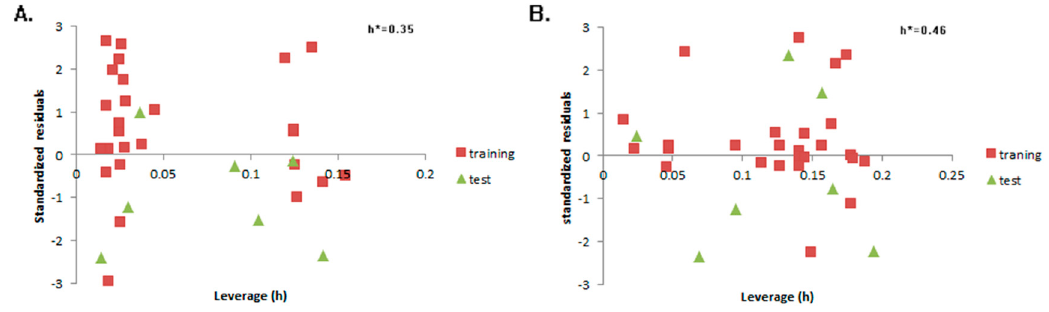
Figure 3. Residuals vs. Leverage Williams plots of the aconitine Topomer CoMFA ( A ) and CoMSIA ( B ) models.